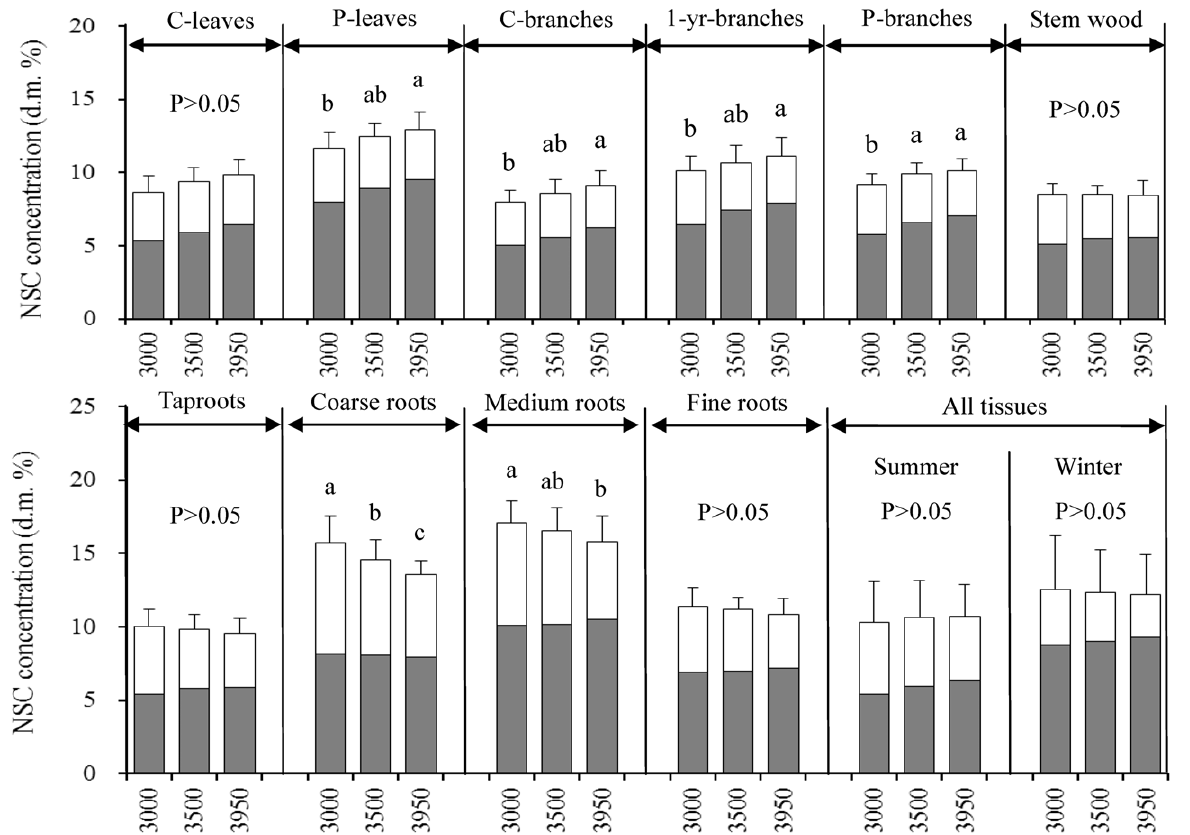
Figure 3. Mean concentrations (calculated using pooled data across sampling dates; n =6) of soluble sugars (dark gray), starch (white), and non-structural carbohydrates (NSC=soluble sugars + starch) in tissues of Quercusaquifolioides plants grown at 3000, 3500, and 3950 m a.s.l. on a SE-facing slope of Mt. Zheduo, Sichuan, SW China. Different letters indicate statistically significant differences ( p , 0.05) in NSC concentration among elevations. Standard error bars ( + 1SE) are given for NSC only.